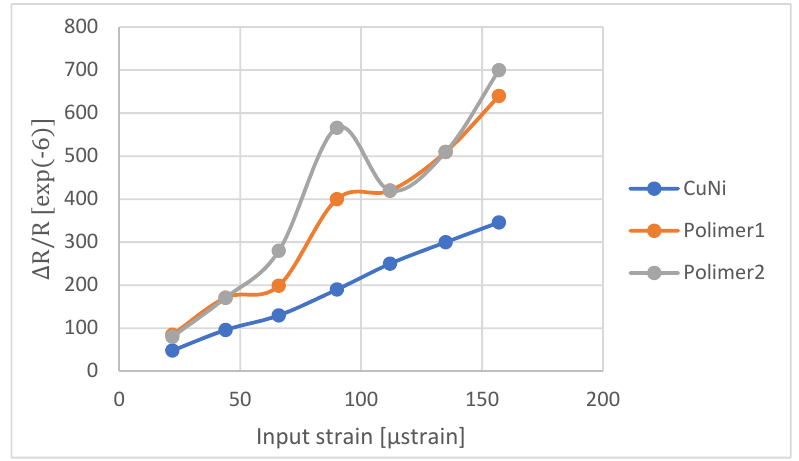
Figure 11. Determination of the strain gauge factor for constant and polymeric sensor.